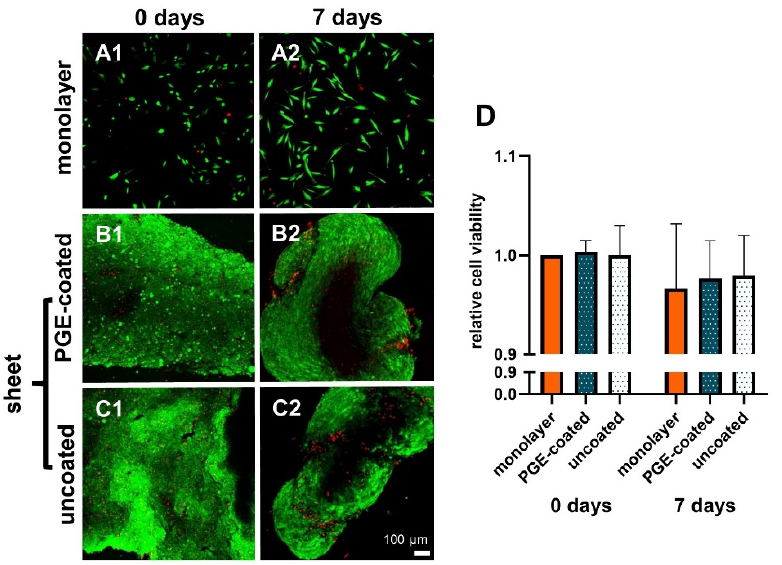
Figure 2. Viability of ligamentocytes in monolayer used for sheet preparation and respective sheets prepared on PGE-coated and uncoated plates and cultured for 7 d in non-adherent culture dishes. 0 d ( A1 , B1 , C1 ), 7 d ( A2 , B2 , C2 ), monolayer of the same cell donor ( A1 , A2 ). Poly(glycidyl ether) (PGE)-coated plates ( B1 , B2 ), uncoated plates ( C1 , C2 ). Green: vital, red: dead cells ( A1 – C2 ). ( D ) Measurements of relative cell viability in monolayer, PGE-coated and uncoated plates after 0 and 7 d, n = 3 independent experiments with ligamentocytes of three different donors. Scale bar: 100 µm ( A1 – C2 ). Statistic: One sample t-test, two-tailed (comparison with day 0 monolayer), paired one-way ANOVA (comparison between the groups) ( D ).